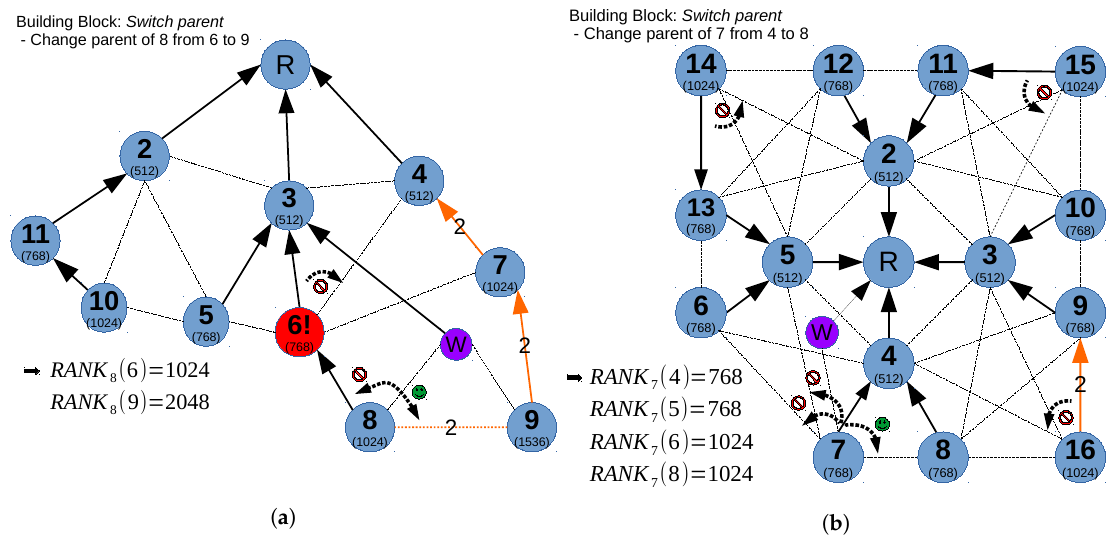
Figure 4. Example of two corner cases in which Whisper nodes are needed. Weights represent the ETX (ETX = 1 by default). ( a ) Example 1; ( b ) Example